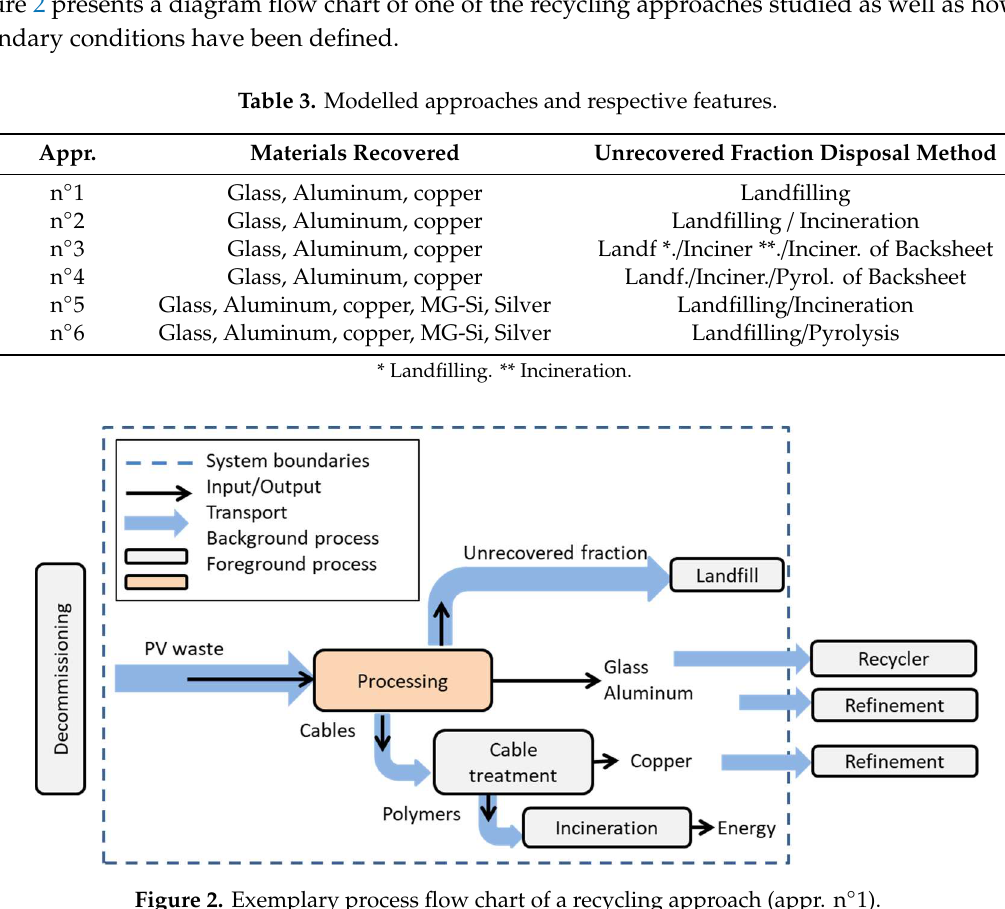
Table 3. Modelled approaches and respective features.